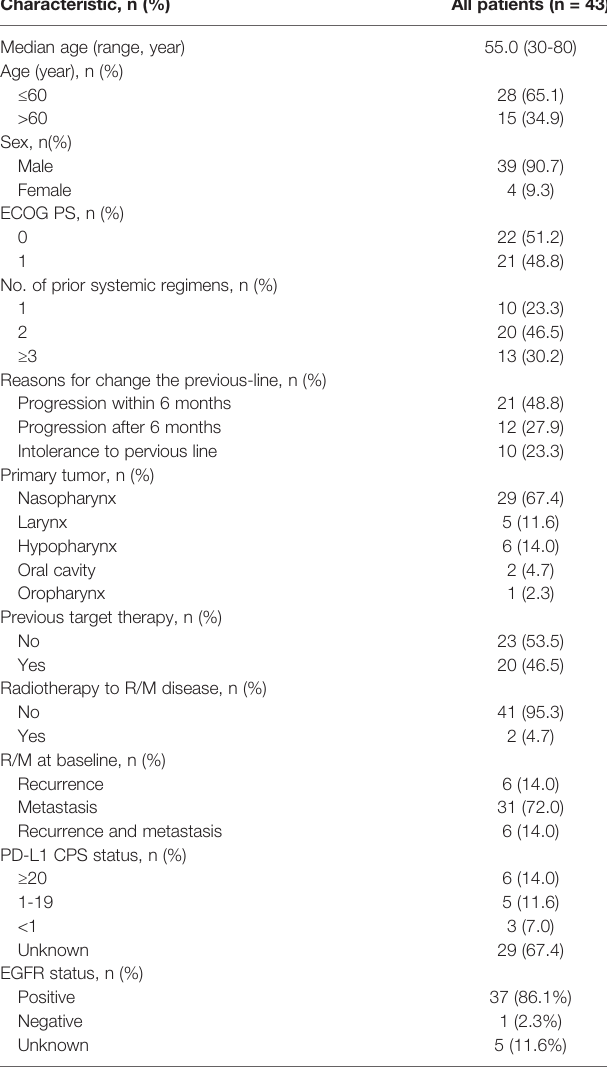
TABLE 1 | Baseline characteristics of study patients. Characteristic, n (%)